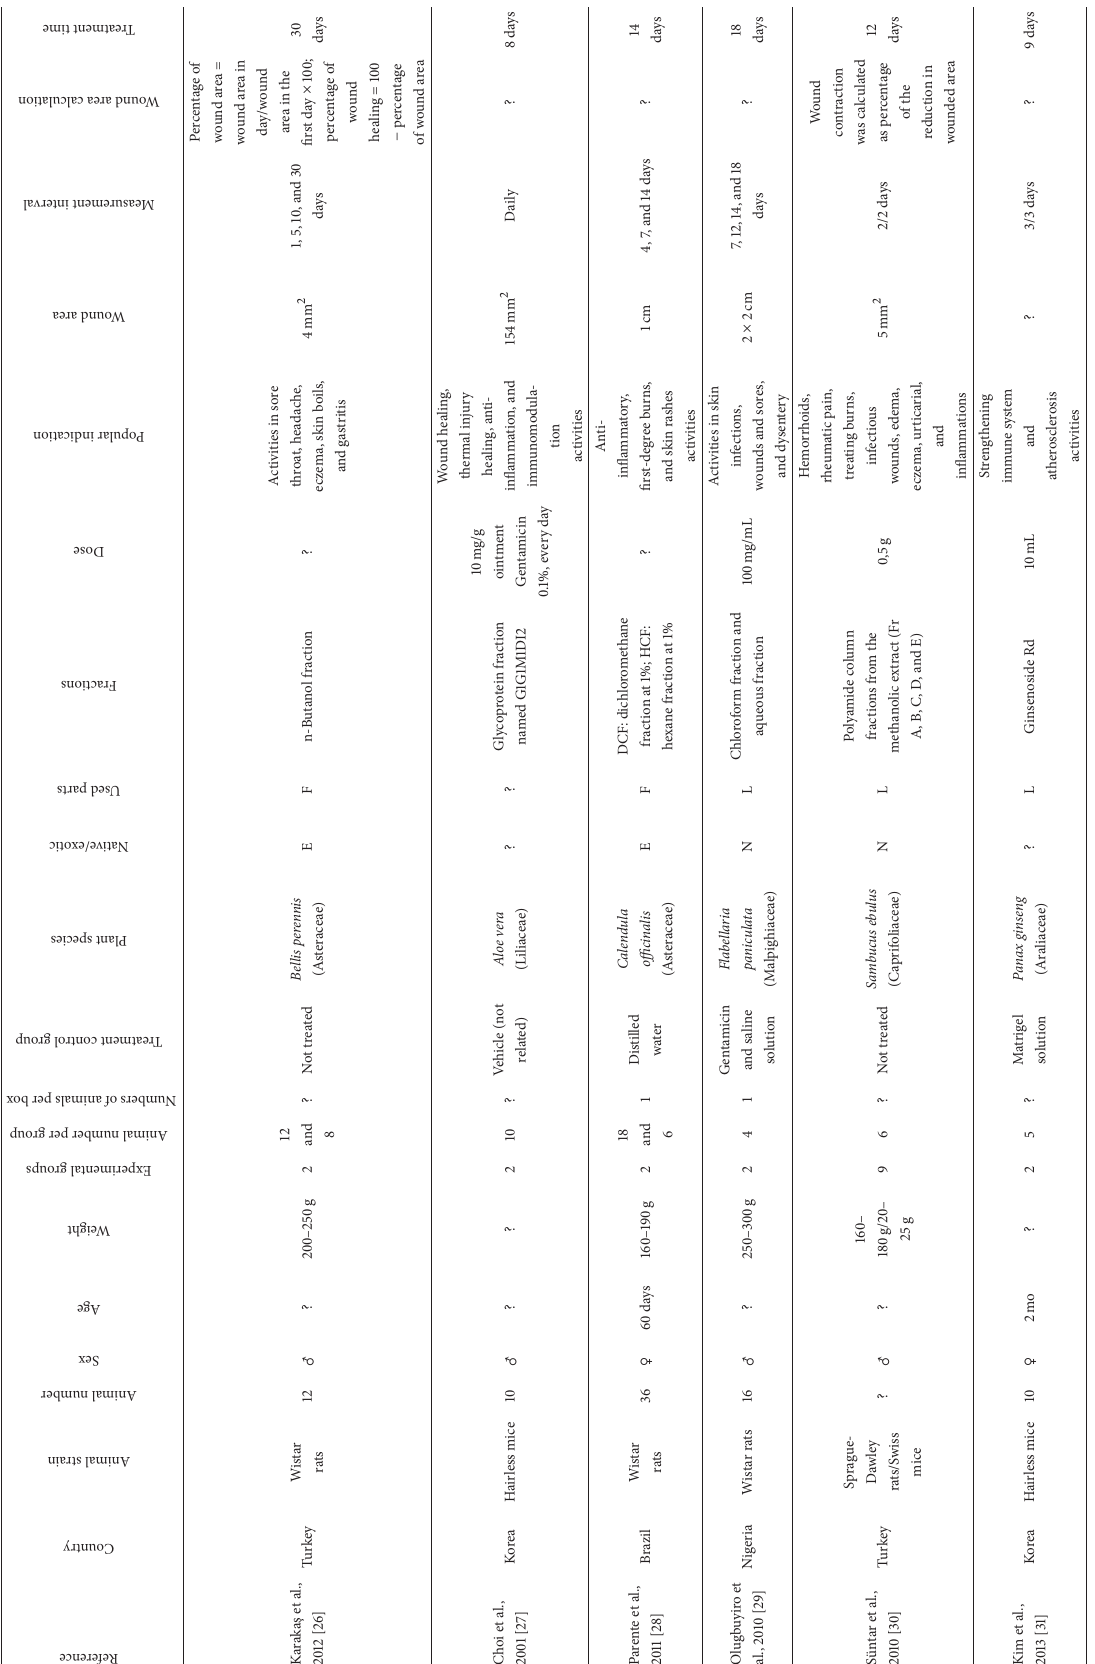
Woundareacalculation